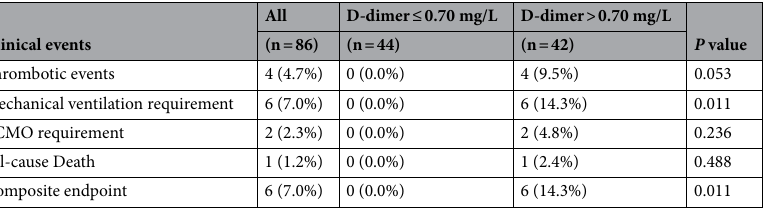
Table 3. Comparison of clinical events between patients with D-dimer ≤ 0.7 mg/L and > 0.7 mg/L. Data are expressed as counts and percentages. The Pearson Chi-Square or Fisher’s Exact Test was used to test the difference between D-dimer groups, as appropriate. ECMO extracorporeal membrane oxygenation; the composite endpoint was the composite of mechanical ventilation requirement, ECMO requirement, or all- cause